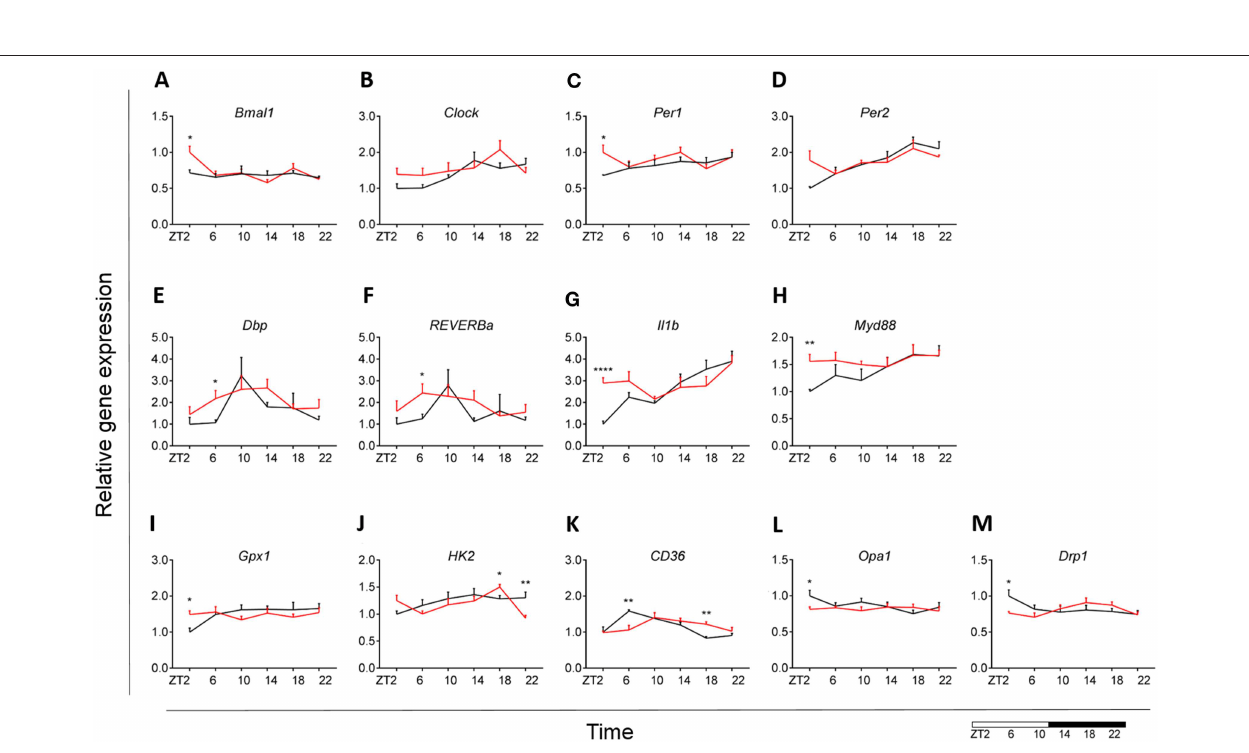
Frontiers in Endocrinology |